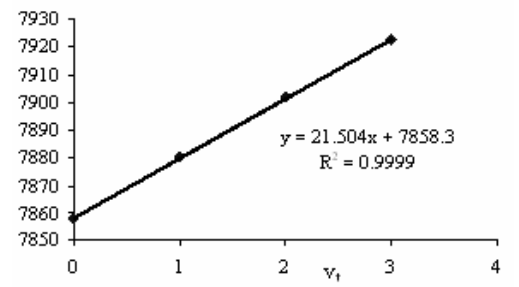
Figure 5 . Plot of B against v